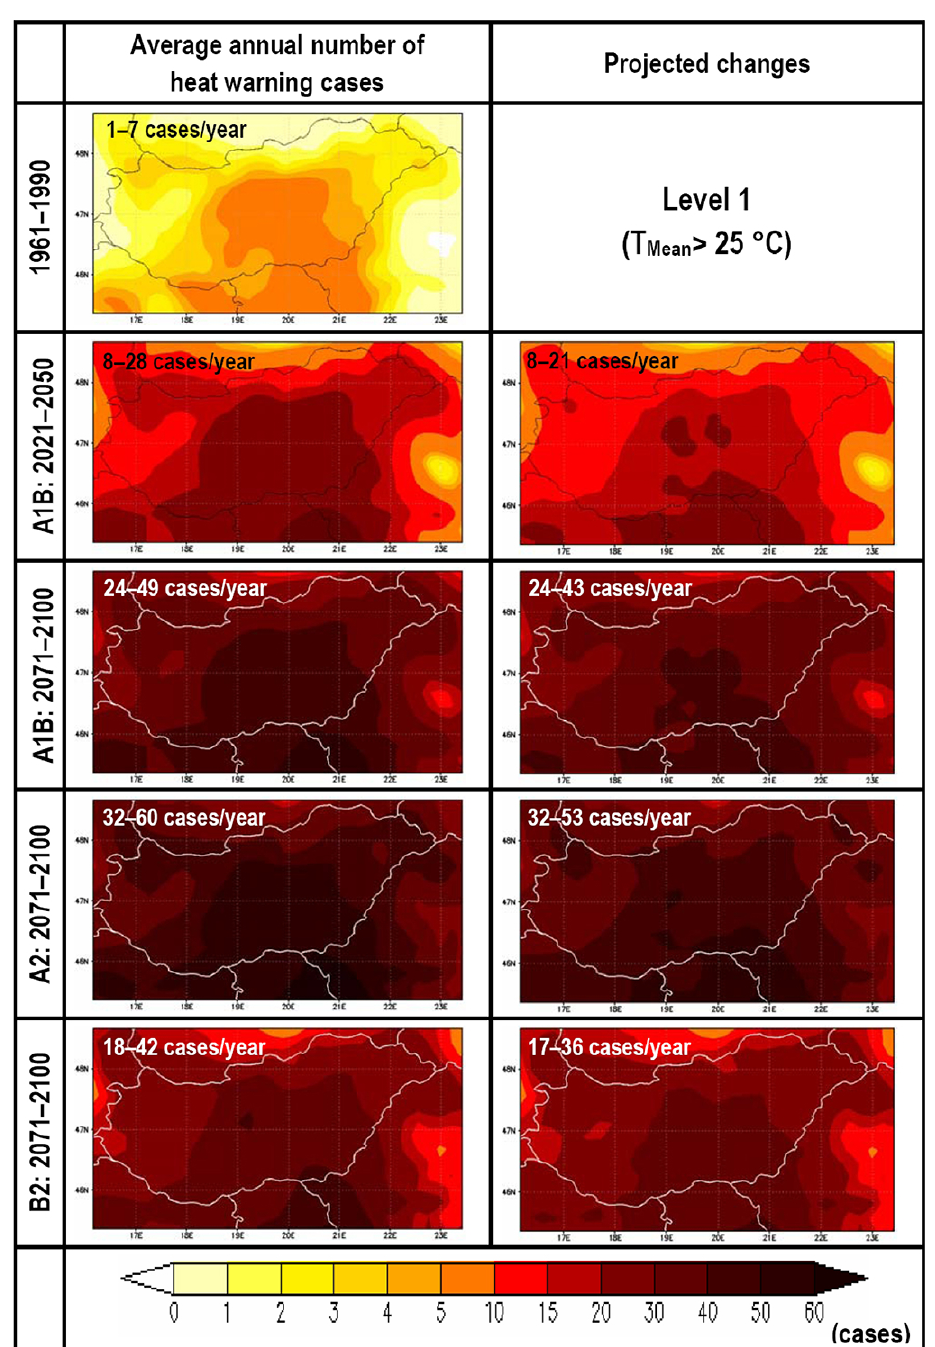
Fig. 3. Simulated occurrences of heat wave warning level 1 (left panel). Projected changes (right panel) are calculated relative to the 1961– 1990 reference